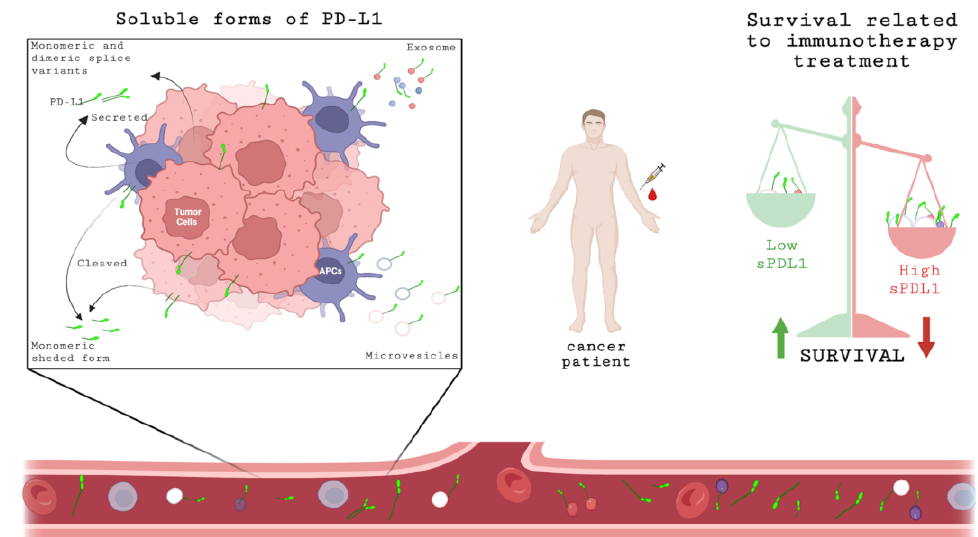
Figure 6. Schematic representation of sPD-L1 expression. Soluble forms of PD-L1 can be released by tumor cells or APCs in different ways: cleaved, secreted monomeric or dimeric splice variants or associated with microvesicles or exosomes. These soluble forms can be detected in serum/plasma.